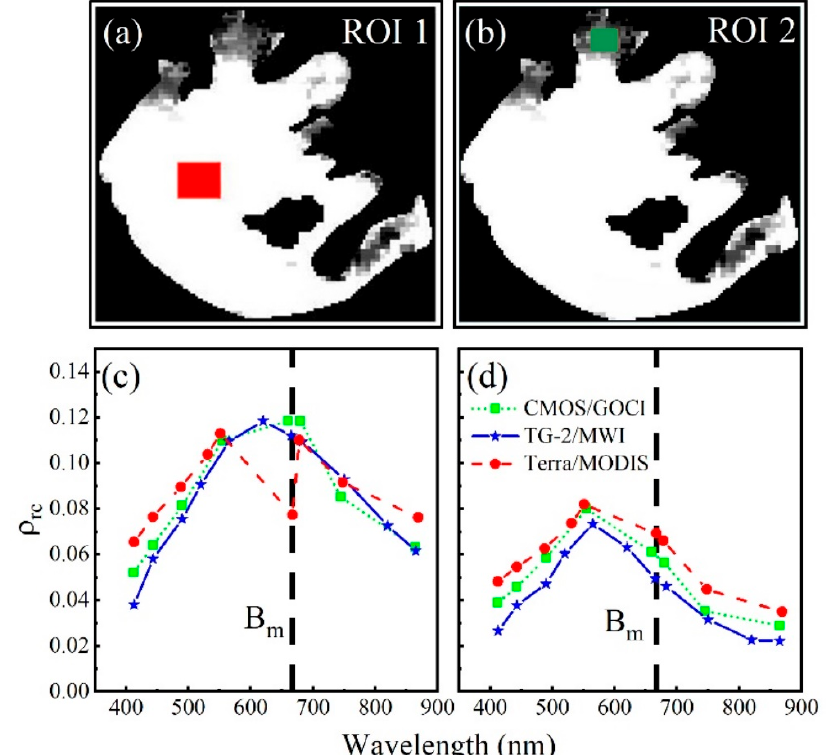
Figure 7. ( a ) Region of interest (ROI) (red frame) in the saturated part of ρ MODIS rc ( 667 ) ; ( b ) ROI (green frame) in the normal part of ρ MODIS rc ( 667 ) ; ( c ) the mean ρ rc of CMOS/GOCI, TG-2/MWI and Terra/MODIS in the red frame; and ( d ) the mean ρ rc of CMOS/GOCI, TG-2/MWI and Terra/MODIS in the green frame.